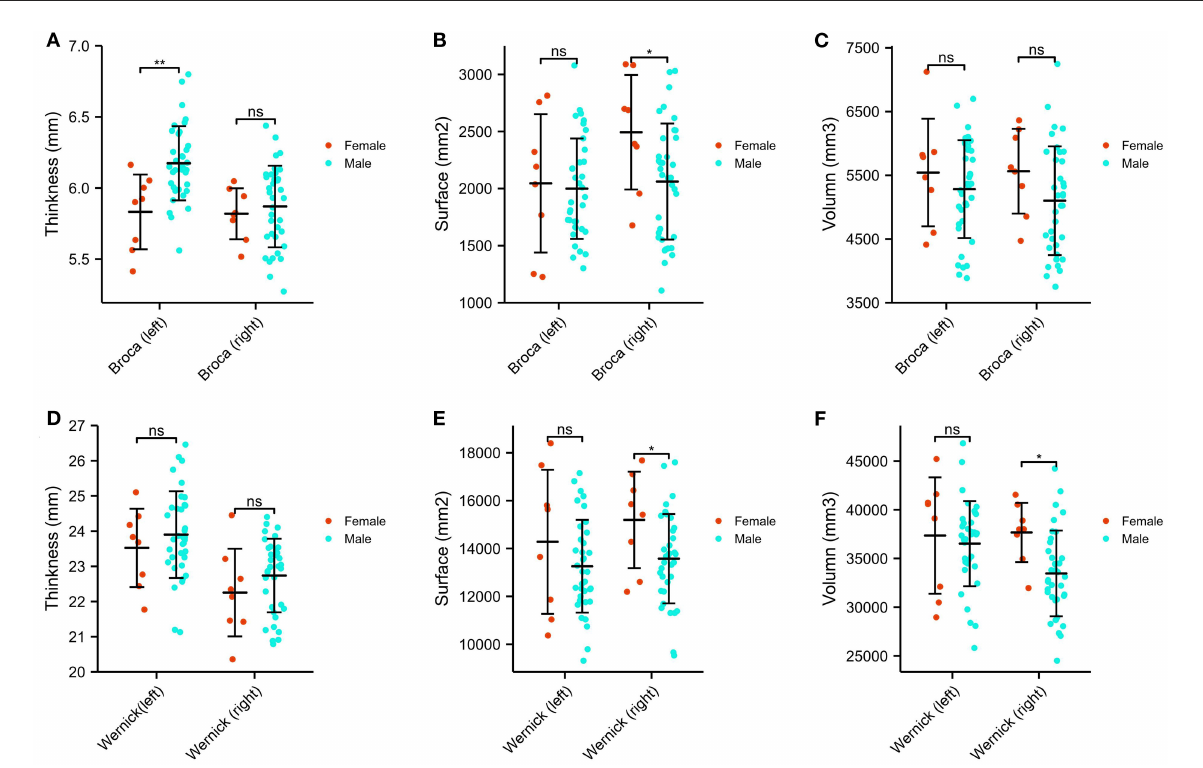
FIGURE3 Sex differences of Broca and Wernicke areas in ASDs. (A) The comparison of the thickness of the bilateral Broca area. (B) The comparison of the surface of the bilateral Broca area. (C) The comparison of the volume of the bilateral Broca area. (D) The comparison of the thickness of the bilateral Wernicke area. (E) The comparison of the surface of the bilateral Wernicke area. (F) The comparison of the volume of the bilateral Wernicke area. * p <0.05, ** p <0.01, ns p > 0.05.